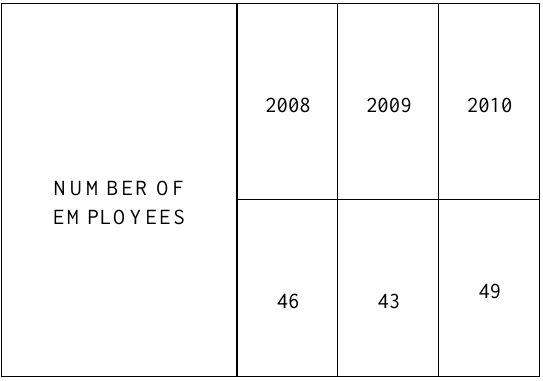
Table 6: Post-Crisis Employee Portfolio of